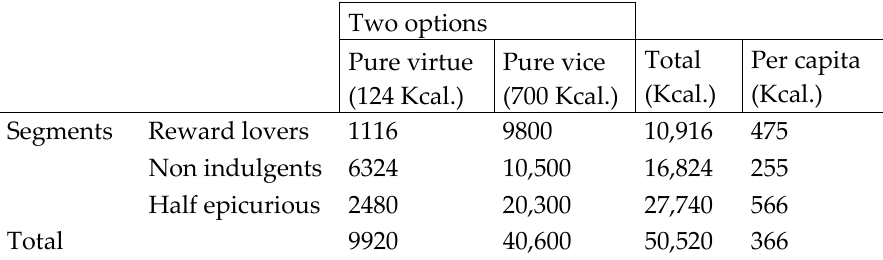
Table 4. Segment’s food choice. Pure virtue-pure vice set (calories).